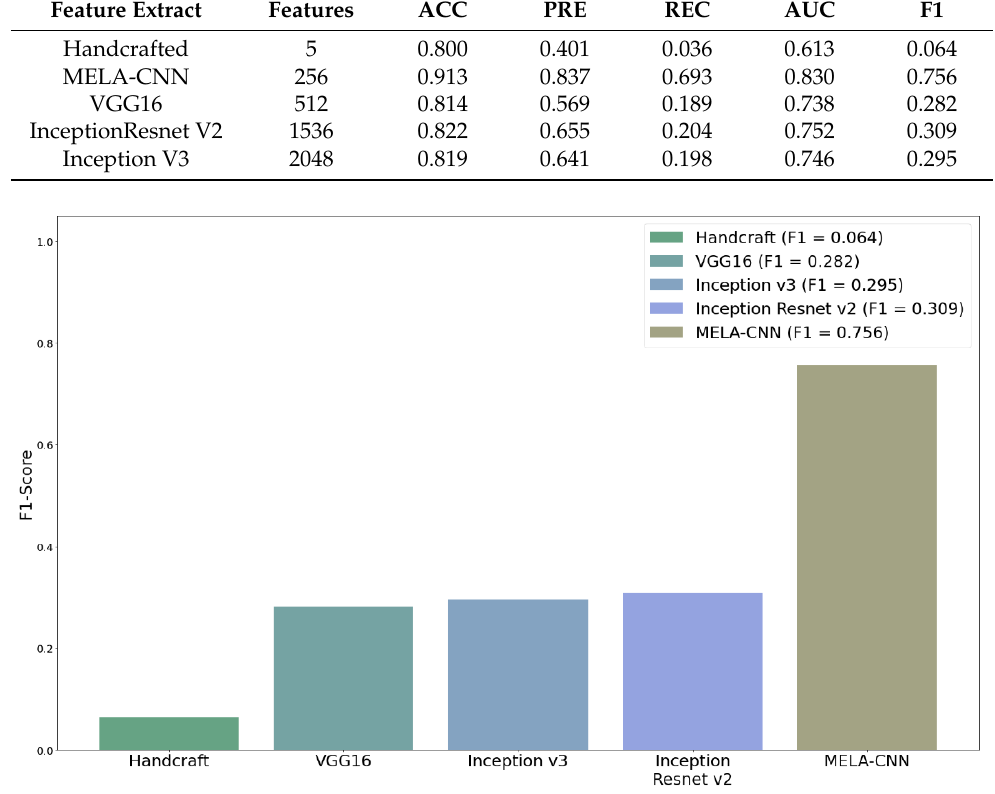
Figure 4. Comparison of F1-score of five feature extraction techniques.